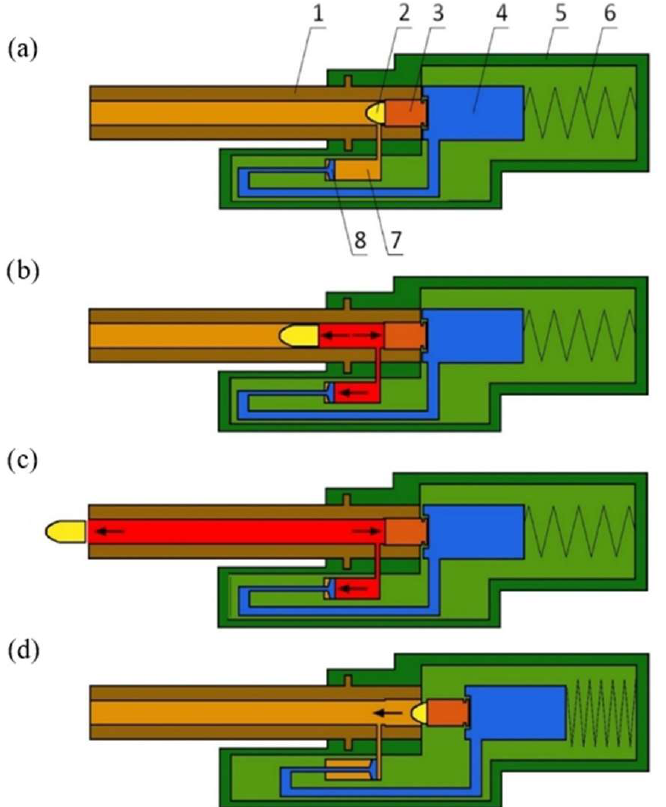
Figure 1. Scheme of action of gas-delayed blowback operation firearm: 1—barrel, 2—projectile, 3—cartridge case, 4—bolt (recoiling assembly), 5—upper receiver, 6—recoil spring, 7—gas chamber, 8—gas piston. ( a ) the initial position: round in the chamber, bolt in forward position and closed barrel; ( b ) the shot is initiated, projectile is moving in the barrel, gases flowing through the gas port to the gas chamber (and/or from the gas chamber to the barrel bore), gases are pressing on the breech face (bolt is accelerated) and on the front of the gas piston (bolt is decelerated); ( c ) the projectile is out of the barrel (has passed the muzzle), gases are pressing on the breech face (bolt is accelerated) and on the gas piston (bolt is decelerated); ( d ) bolt in the rear position, the next round is